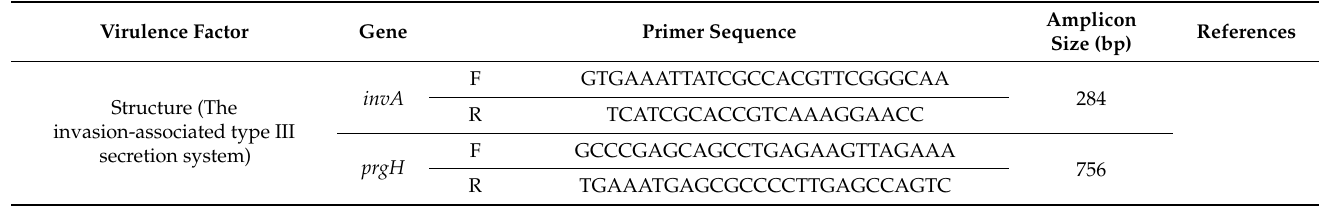
Table 1. Primer sequences used for amplification of virulence genes in Salmonella spp.